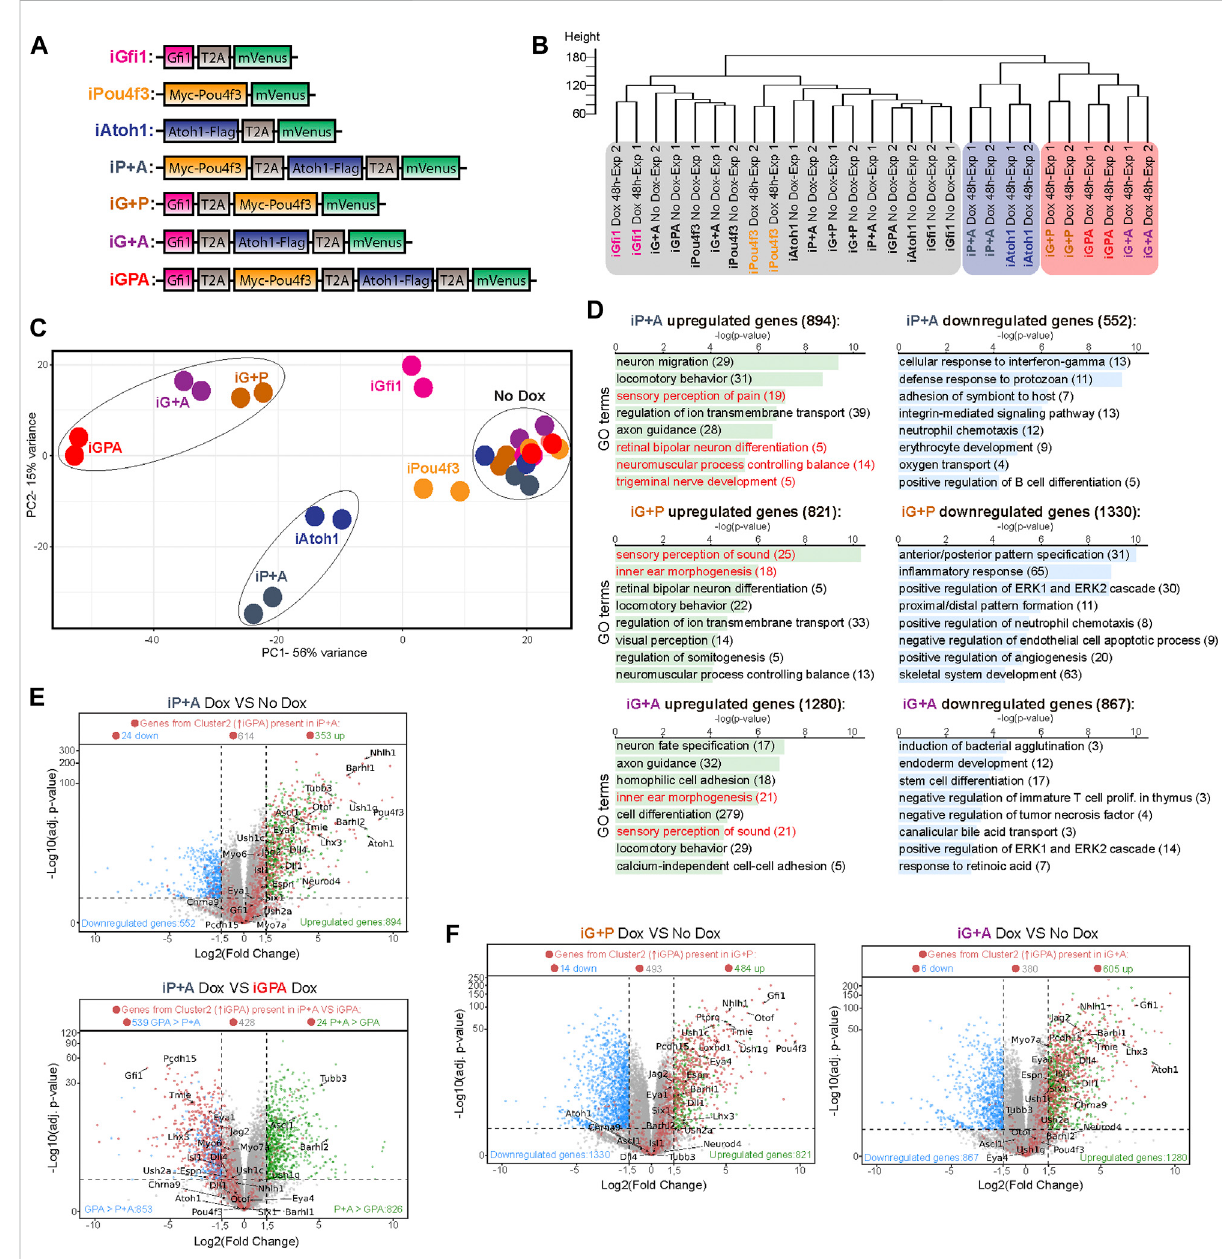
Transcriptome analysis of differentiation supported by TF combinations reveals G fi 1 is critical for HC switch. (A) Diagram of the Dox-inducible taggedTFconstructsusedtoengineerthesevendifferentESCslinescapableofoverexpressingdifferentTF combinationsuponDoxtreatment.T2A, 2A self-cleaving peptide derived from thosea asigna virus. (B) Dendrogram showing hierarchical clustering of the various expression pro fi les obtained from EBs induced to express different TF combinations, as indicated in (A) . 48 h of Dox-treated EBs and no Dox exposed EBs were collected at day 6 of culture for transcriptome analysis. Exp1 and Exp2 corresponds to two biological replicates. (C) Principal component analysis (PCA) obtained from the transcriptome pro fi les of all Dox-inducible EBs lines that contained different TF combinations. EBs were grown in the presence or absence of Dox for 48 h before collection at day 6 of culture. The PCA explain 56% (PC1) and 15% (PC2) of total variance. (D) Gene ontology (GO) analysis performed for all the differentially expressed genes of each cell line iP+A, iG+P and iG+A when comparing Dox treated EBs versus non-treated EBs at day 6. The total number of selected differentially expressed genes (adjusted p -value ≤ 0.05 and log2-fold change ≤ − 1.5 or ≥ 1.5) are indicated. (E) Volcano plots showing the log2-fold change of mRNA transcript levels and the log10-adj. p -value obtained when comparing iP+A-Dox treated EBs versus iP+A control EBs (not treated) as well as comparing iP+A-Dox treated EBs versus IGPA Dox treated EBs at day 6 after 48 h of Dox exposure. Each dot represents an expressed gene. Blue and green dots indicate genes signi fi cantly downregulated (log2-foldchange ≤ − 1.5and p -value ≤ 0.05)andupregulatedgenes(log2-foldchange ≥ 1.5and p -value ≤ 0.05),respectively.Reddotsrepresentthe genes previously identi fi ed in cluster 2 (C-2: containing genes enriched only in GPA from Figure 1E). Total counts of the red dots for each category (downregulated, upregulated and non-differentially expressed genes) are show on top of each volcano plot. (F) Volcano plot shown as described in (E) but highlighting the differentially expressed genes in Dox treated iG+P EBs compared with no Dox control iG+P EBs as well as Dox treated iG+A EBs compared with no Dox control iG+A